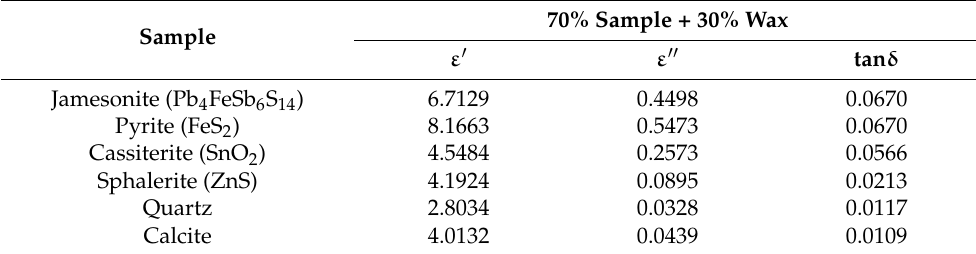
Figure 2. The ability of microwave absorption of minerals and gangues: ( a ) RE and ( b ) heating curve. Table 4. Dielectric constants of the sample components at 2.45